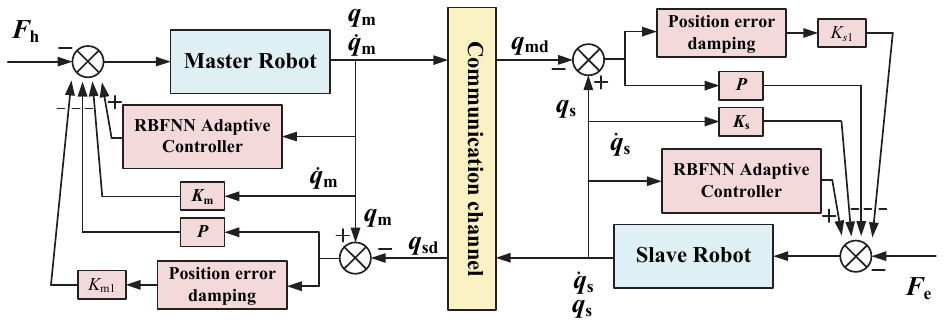
Figure 1. The control block diagram of the